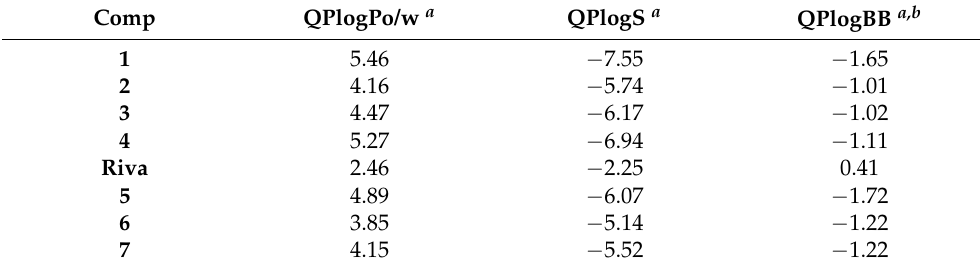
Table 1. Lipophilicity, solubility and blood-brain barrier permeation calculated for target compounds and rivastigmine.